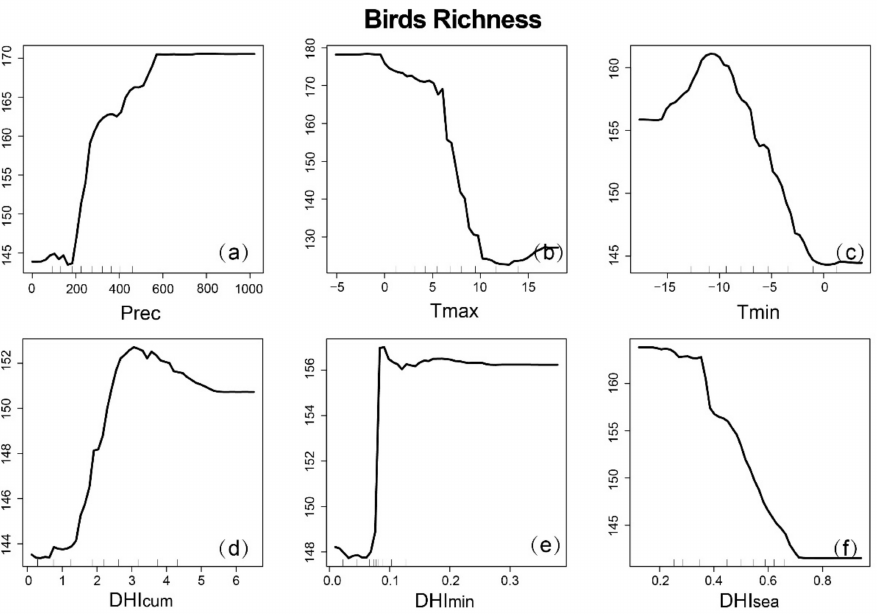
Figure 10. Partial dependence map of bird richness based on RF, depending on climatic variables and dynamic habitat indices (DHIs): ( a ) annual cumulative precipitation; ( b ) annual maximum temperature; ( c ) annual minimum temperature; ( d ) DHI cum ; ( e ) DHI min ; ( f ) DHI sea